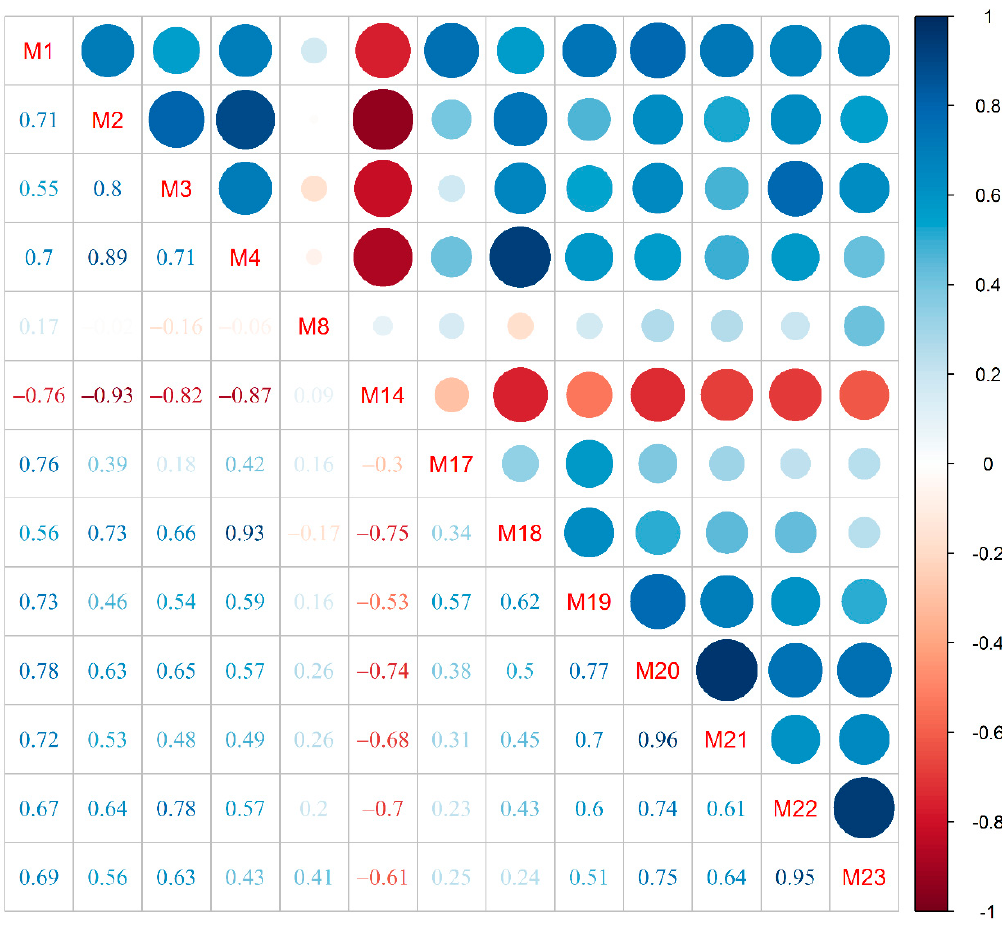
Figure 6. Spearman’s rank correlation coefficient chart of 13 candidate BD-IBI metrics.